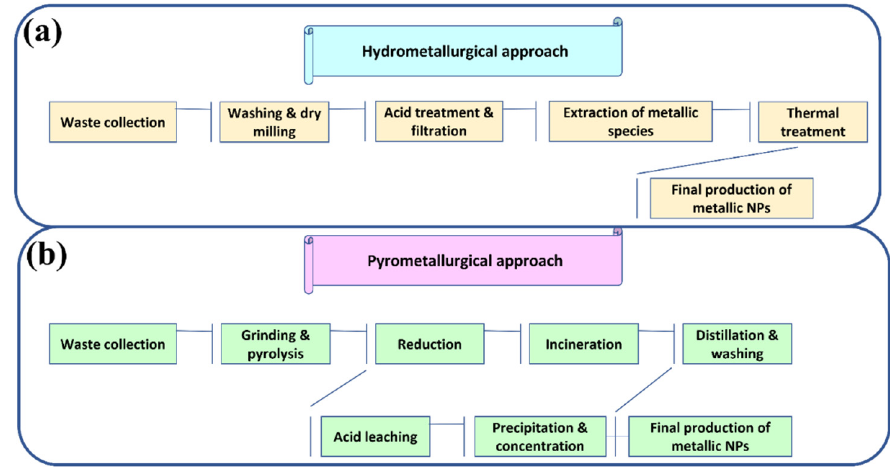
Figure 6. Process steps of ( a ) hydrometallurgical and ( b ) pyrometallurgical approaches to recover metallic species from various wastes.